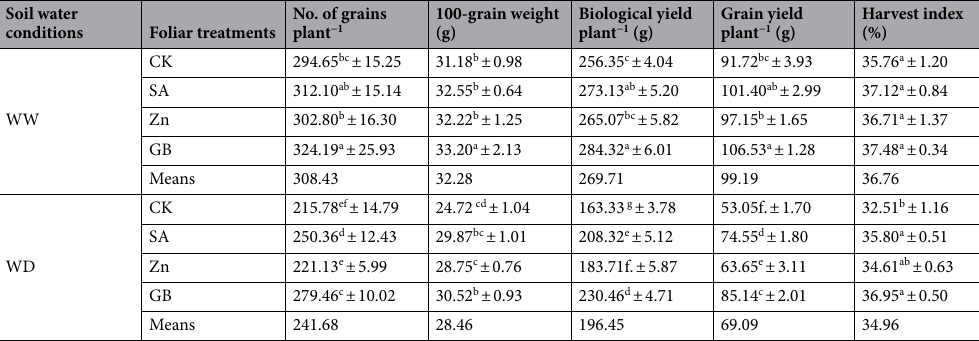
Table 2. Effect of soil water conditions and foliar treatments on the number of grains, 100-grain weight, biological yield, grain yield, and harvest index. Values are means (± SE) of three replicates. For L.S.D.’s results, means with different letters indicate that means are different. at 95% confidence level. WW, well-watered; WD, water-deficient; CK, control (double distilled water); SA, salicylic acid; Zn, Zinc; GB, Glycine betaine.